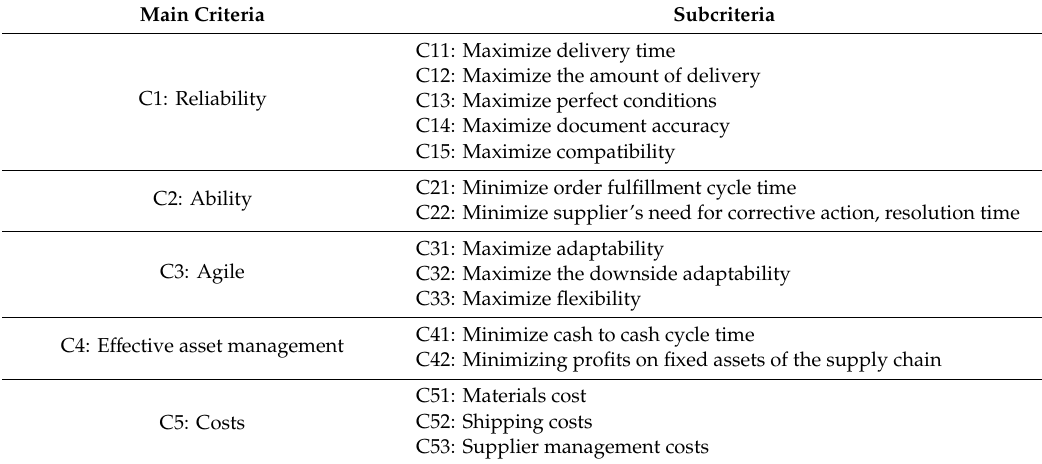
Table 4. List of main and secondary criteria